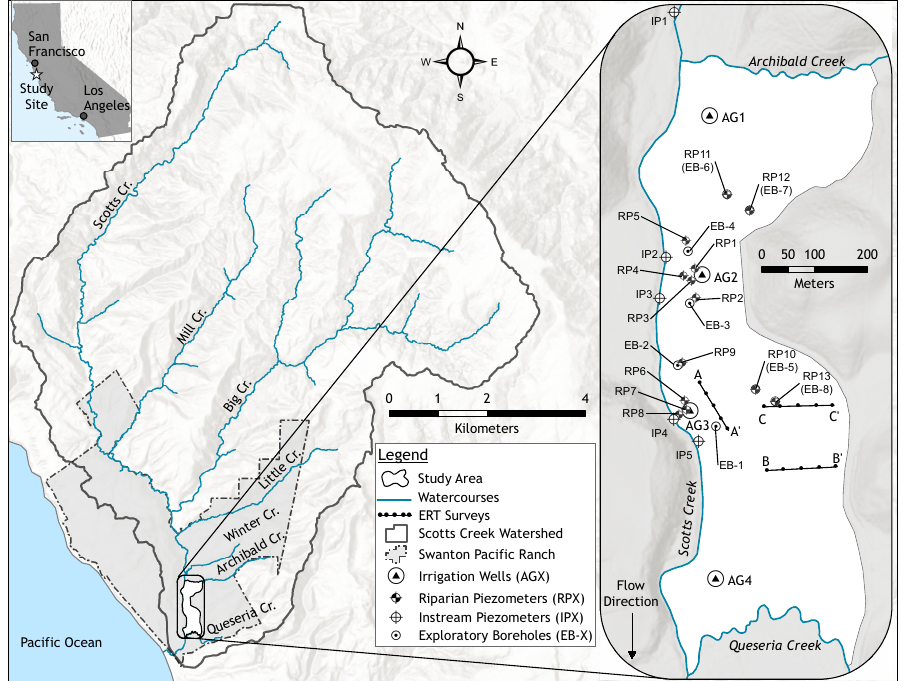
Figure 1. Map of the Scotts Creek (Cr.) watershed (center) and the study site (right) on the California central coast (top left). The locations of agricultural wells (AGX), instream (IPX), exploratory bore- holes (EB-X), and riparian (RPX) piezometers, electrical resistivity surveys (ERT), and the study site bounding streams are